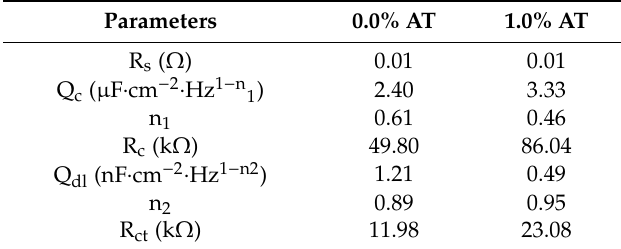
Figure 10. The equivalent circuit (R(QR)(QR)) ( a ) used to fit the EIS data and the fitted Nyquist data ( b ) from the equivalent circuit with or without AT. Table 3. Fitting parameters for the electrical equivalent circuit